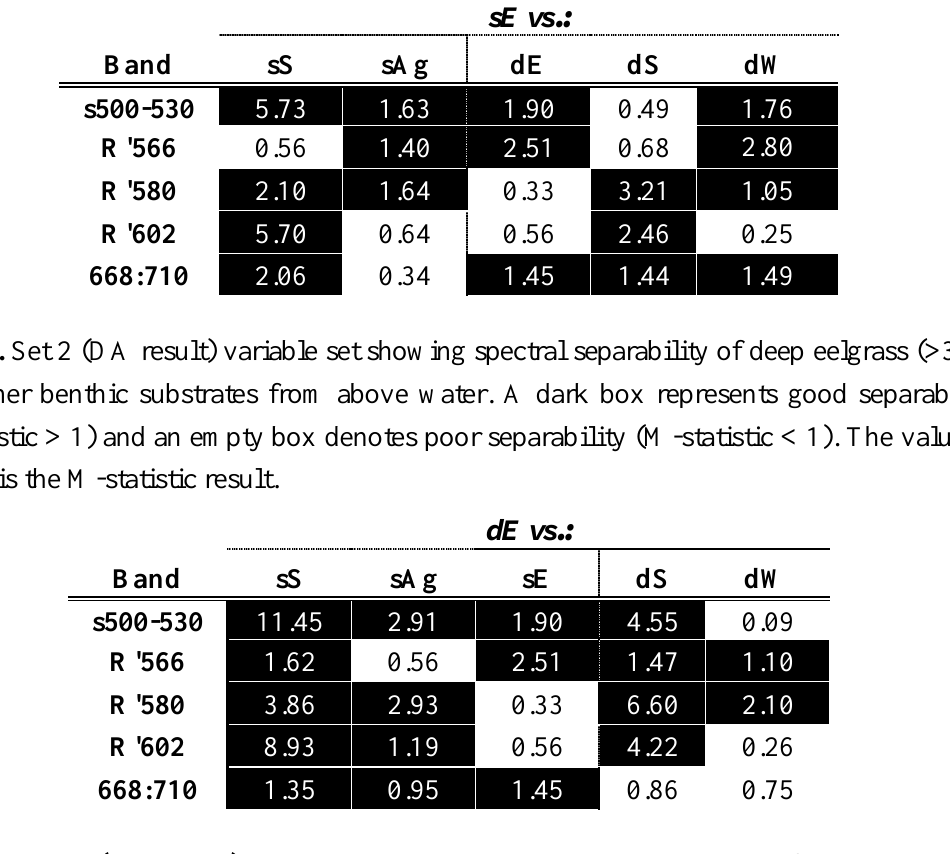
Table 7. Set 2 (DA result) variable set showing spectral separability of water-corrected shallow eelgrass (<3 m) from other water-corrected benthic substrates. A dark box represents good separability (M-statistic > 1) and an empty box denotes poor separability (M-statistic < 1). The value in the box is the M-statistic